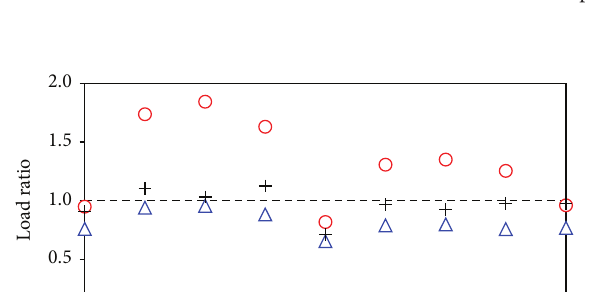
Figure 6: Failure patterns of test specimens.